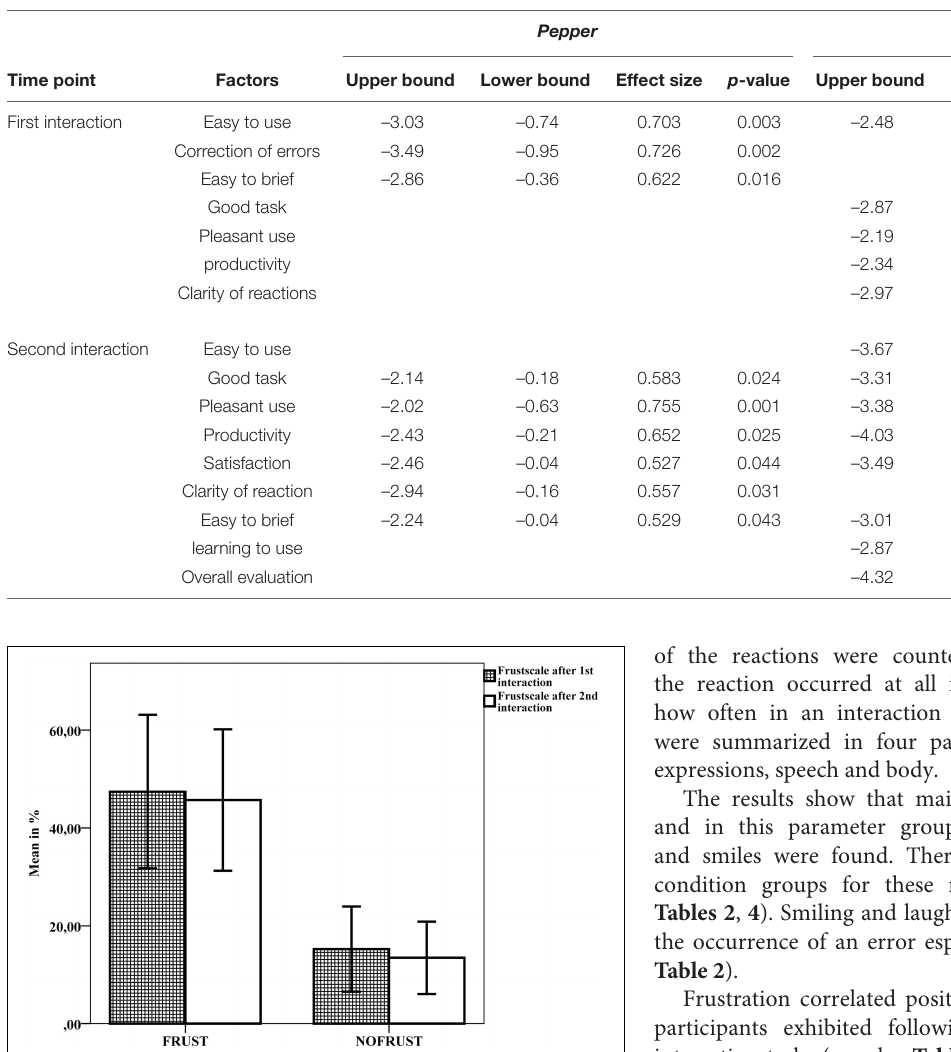
TABLE 5 | The table shows the results of the robot rating for both robots in comparison between the condition groups for each interaction (see also section “Robot Rating: Robots were evaluated different in condition groups”).